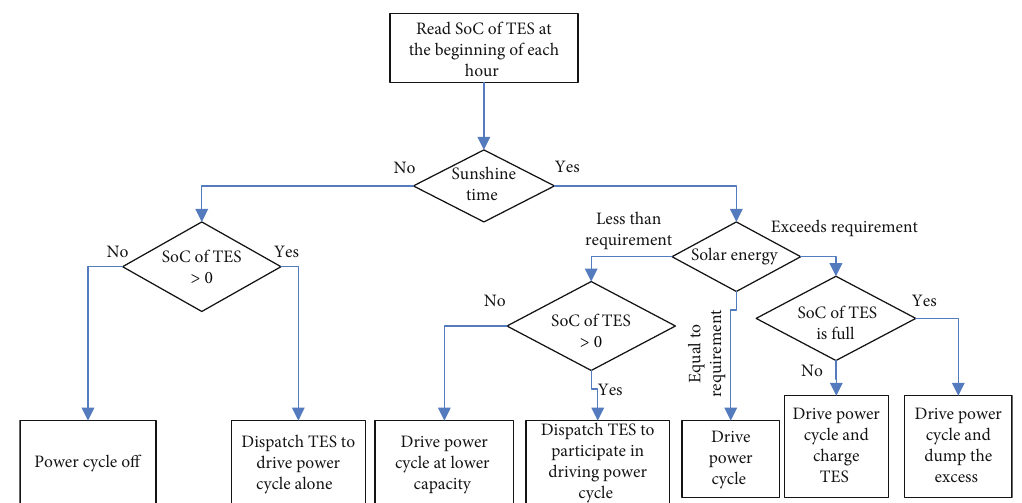
Figure 10: Flow chart of charging and discharging methodology of TES.